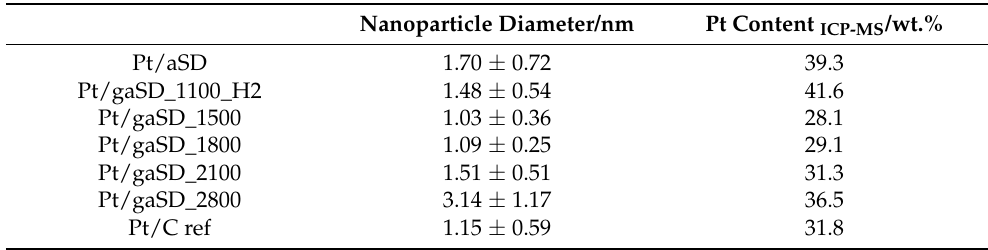
Table 1. Nanoparticle diameter and platinum content of catalysts, obtained from TEM images and ICP-MS measurements.